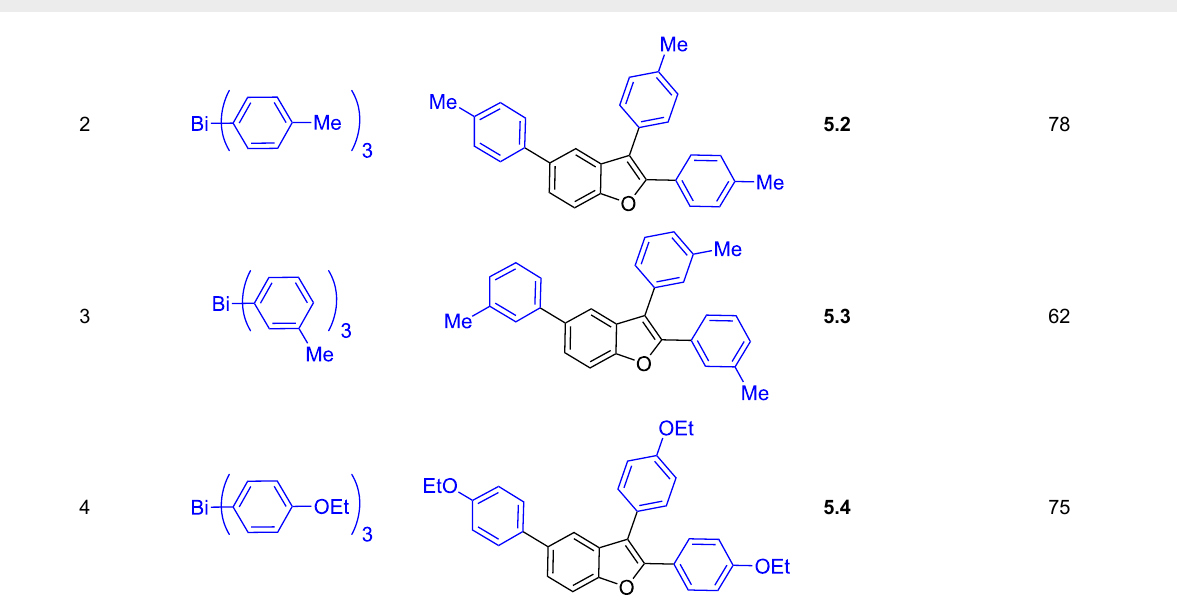
Table 7: Tris-coupling of 2,3,5-tribromobenzofuran. a